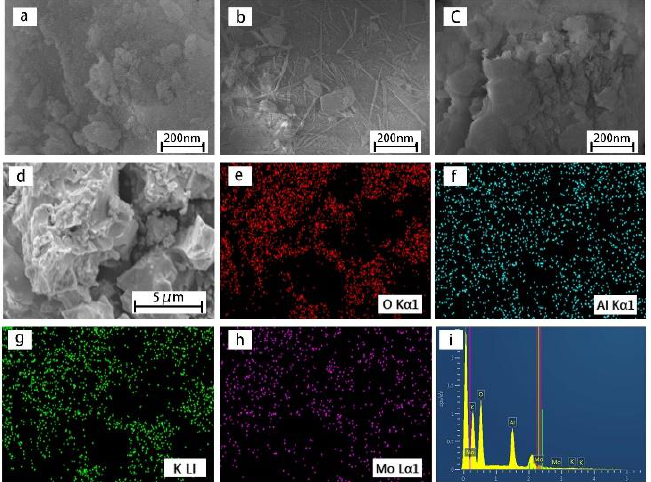
Figure 4. ( a ) SEM image of the fresh Mo/Al catalyst, ( b ) SEM image of the fresh K/Al catalyst, ( c ) SEM image of the fresh K-Mo/Al catalyst, ( d ) SEM image of the fresh K-Mo/Al catalyst and the corresponding EDS mapping images for O ( e ), Al ( f ), K ( g ) and Mo ( h ), ( i ) EDS spectra of the fresh K-Mo/Al catalyst.